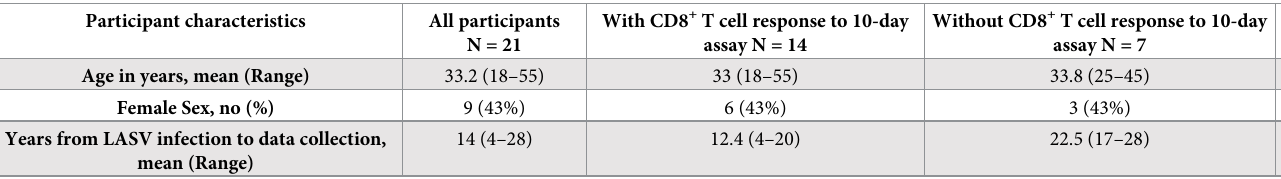
Table 2. Participant